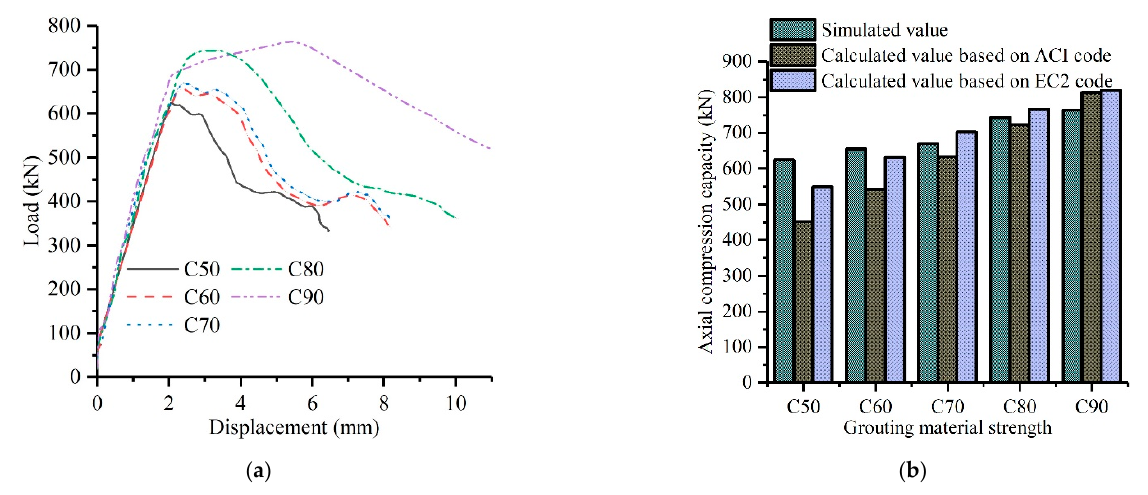
Figure 16. Different grouting strengths: ( a ) comparison of load–displacement curves of different grouting strengths; ( b ) comparison of the calculated and simulated values of different grouting strengths.